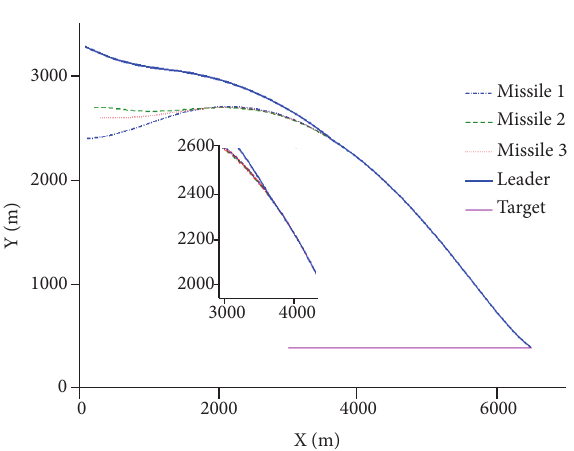
Figure 9. Velocity curves of the following interceptors obtained using the regular cooperative control strategy.